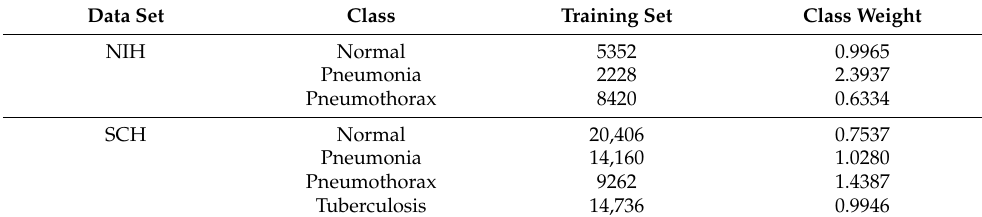
Table 7. Class weights of the training set of the NIH and SCH data sets.